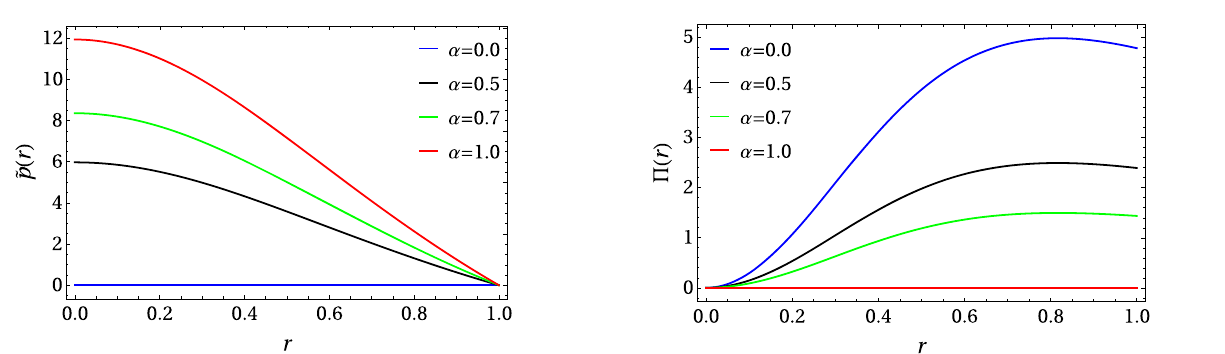
Fig. 1 Isotropization:theradialpressure[ ˜ p × 10 3 ]fordifferentvalues of the parameter α for a distribution with compactness M / R = 0 . 2